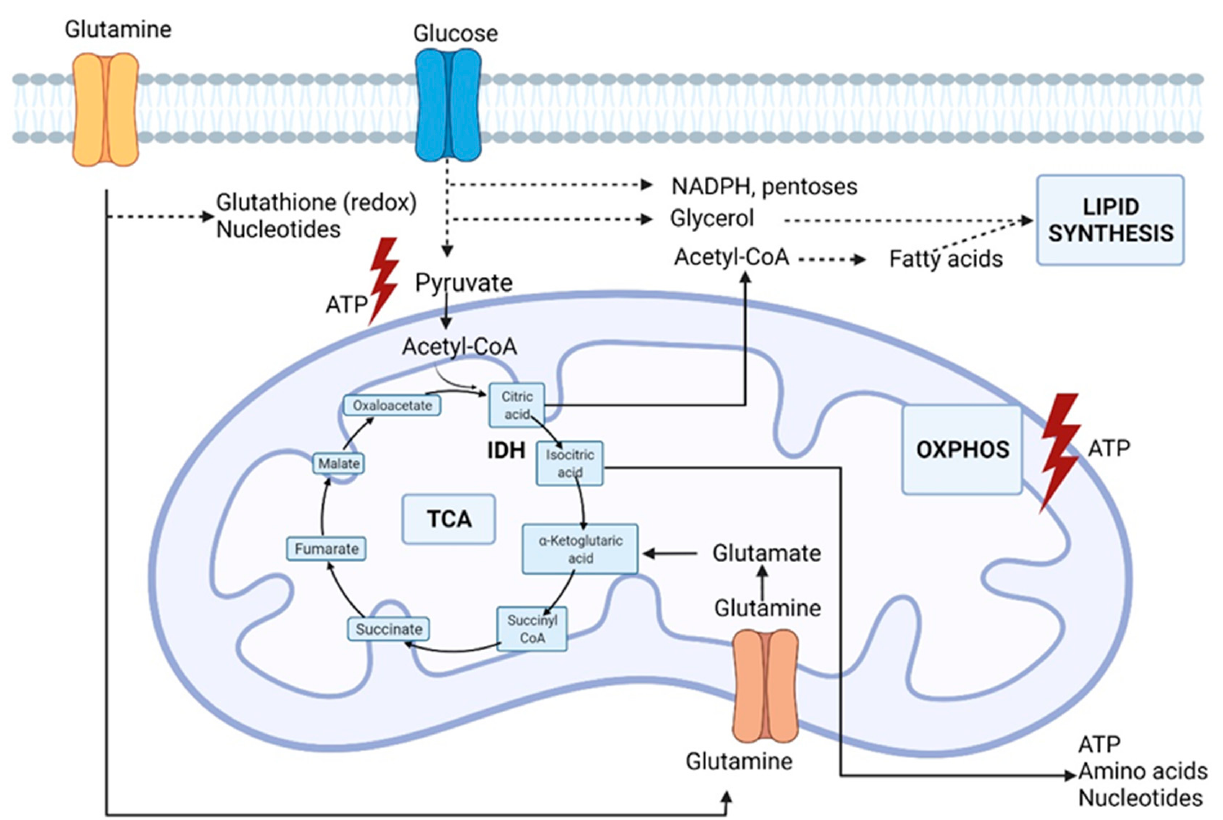
Figure 2. Glutamine metabolic pathways involved in lung cancer cell metabolism. IDH (isocitrate dehydrogenase), OXPHOS (oxidative phosphorylation), TCA (tricarboxylic acid cycle). Original figure drawn with Biorender.